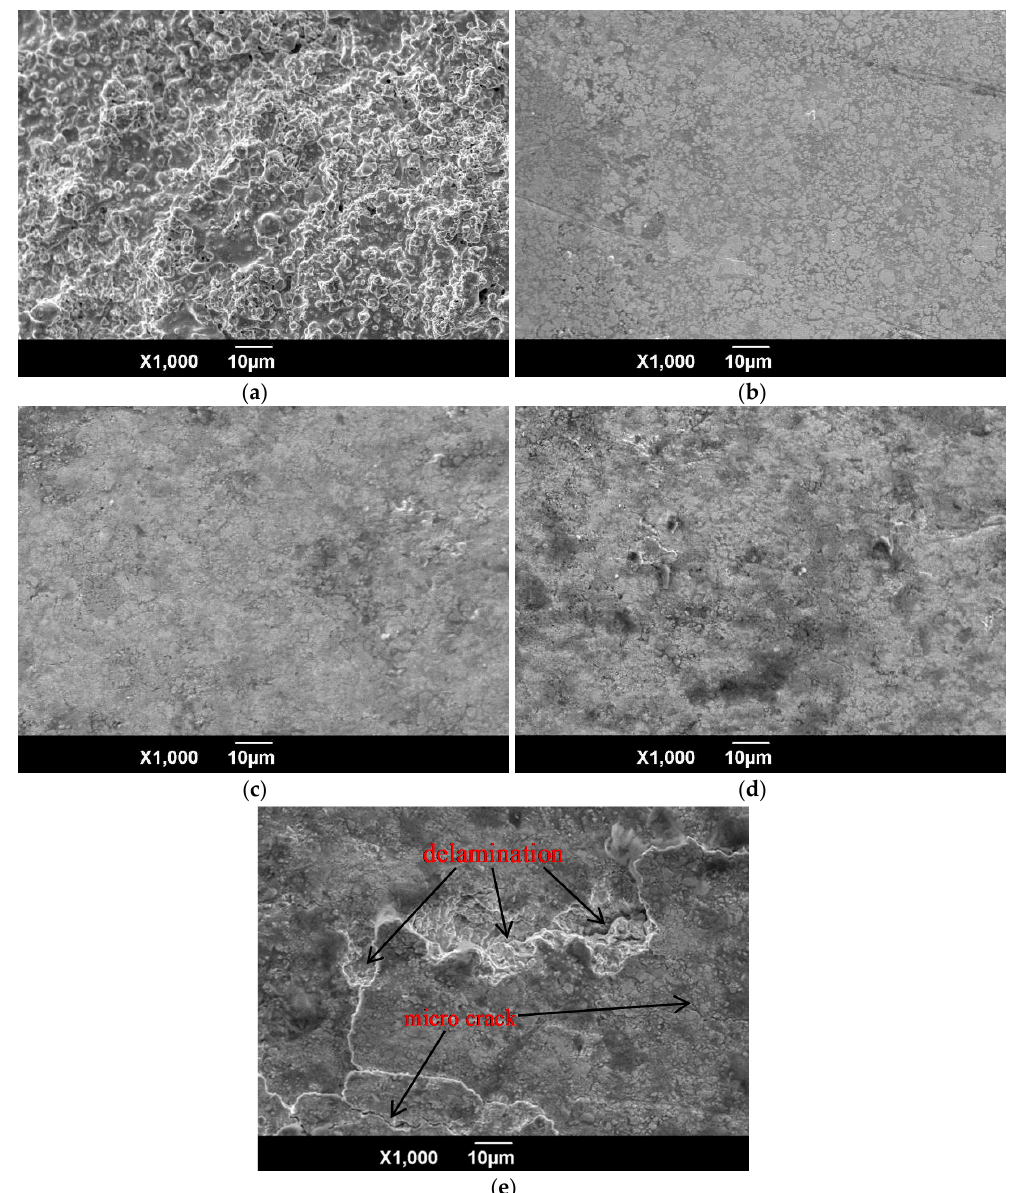
Figure 4. SEM micrographs of specimens with different surface treatments: ( a ) SP + H; ( b ) SP + H +